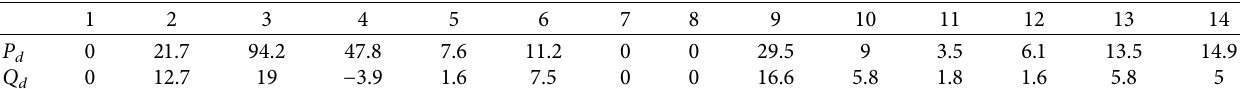
Table 16: Load demand details.